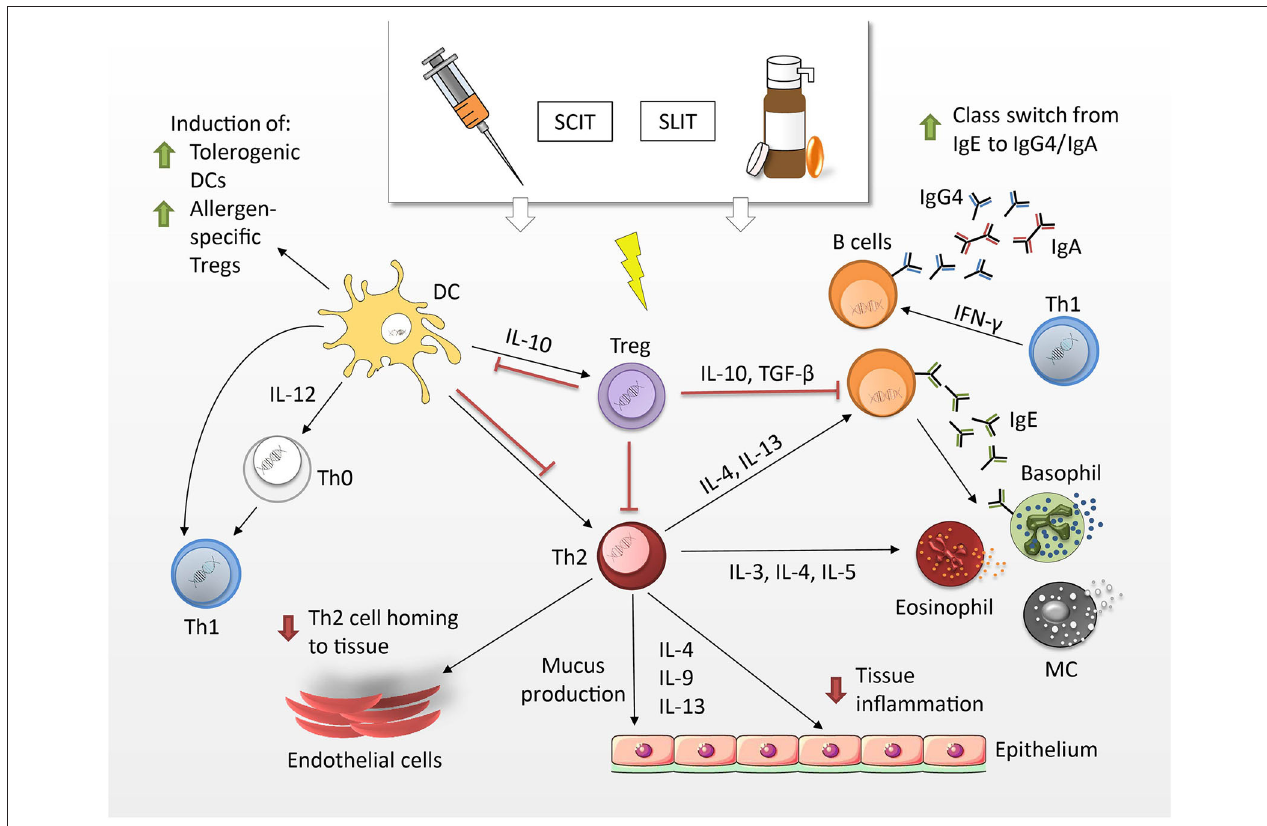
FIGURE 3 | Mechanisms of allergen-specific immunotherapy. Tregs produce cytokines such as IL-10 and TFG- β , which have the potential to suppress Th2 responses. Upon induction of tolerogenic DCs Th1 are mobilized at the expense of Th2 cells. They produce IFN- γ and stimulate the production of IgG4 and IgA antibodies by means of class switching. IgG4 antibodies can block allergen-induced MCs, basophils and eosinophils and hence, limit allergic symptoms by decreasing mediator release ( 178,